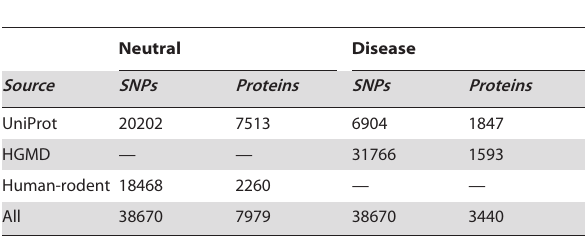
Table 1. Composition of the training sets.